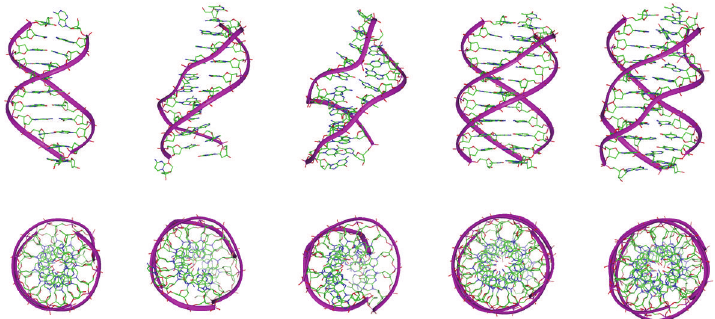
Figure 6: Representation of the average structures (obtained by relaxing Cartesian average in the 8th → 10th nanosecond) for the di ff erent duplexes and triplexes considered here.